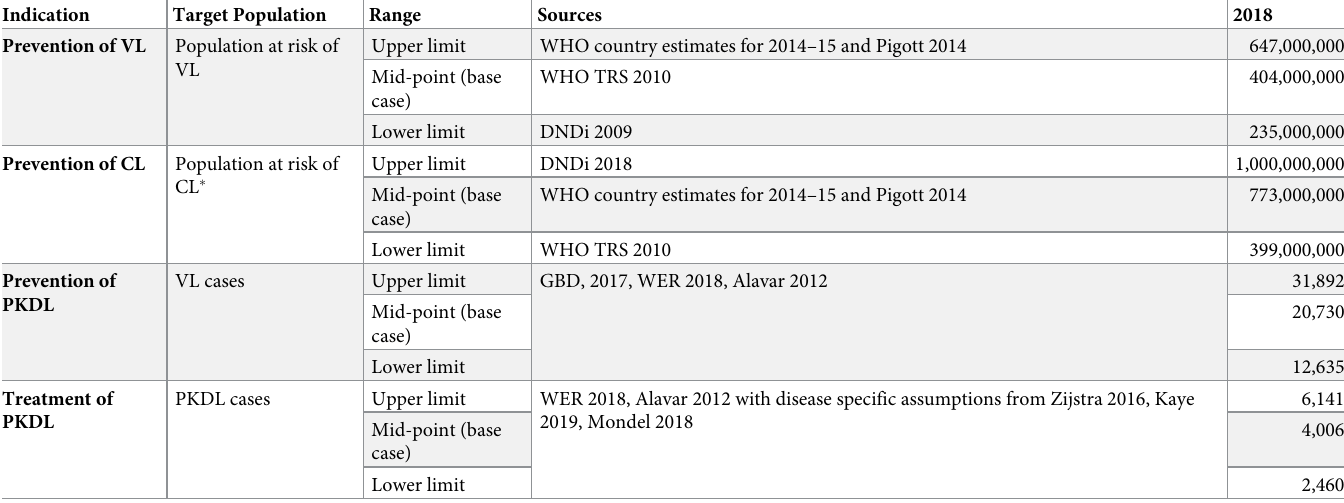
Table 5. Target population ( � 30% of this population is assumed being also at risk of VL).